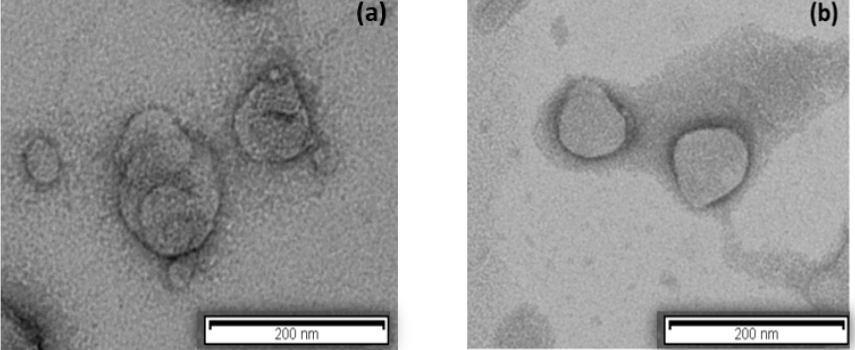
Figure 3. Transmission electron microscopy images of ( a ) AST-SLN and ( b ) AST-SSLN.